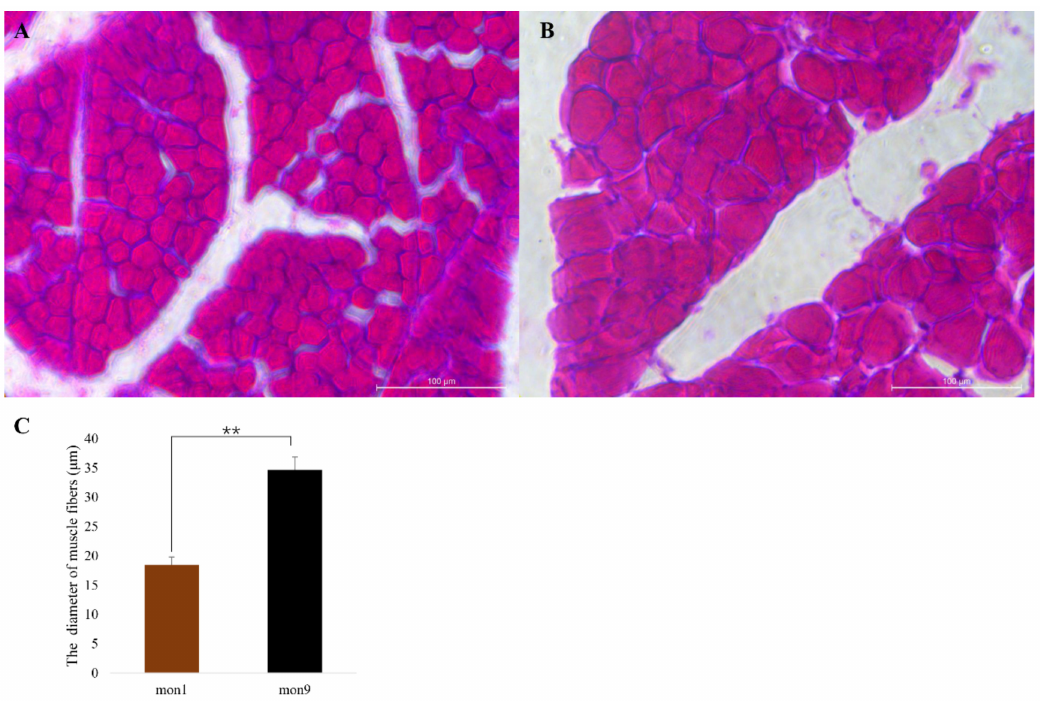
Figure 1. Diameter of longissimus dorsi fibers from Wu’an goats: ( A ) A representative transverse section of longissimus dorsi fibers from a 1-month-old goat. ( B ) A representative transverse section of longissimus dorsi fibers from a 9-month-old goat. ( C ) Muscle fiber diameter statistics for the mon1 and mon9 groups; three fibers per group were measured. Data are shown as the mean ± SE. ** p <